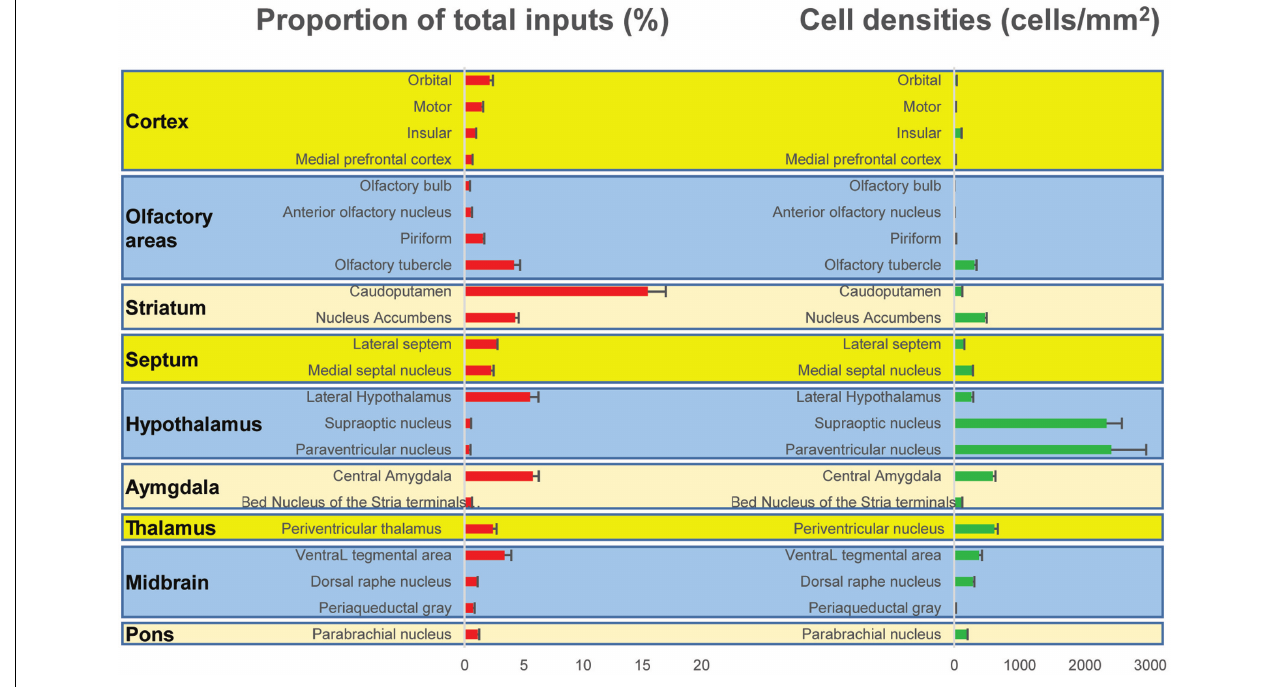
FIGURE 3 | Statistical analysis of the monosynaptic inputs (Left) Proportion of input neurons for BF cholinergic neurons. The values are the normalized ratio of the cell number in each area against the total number of input neurons. Error bars represent the SEM. n = 4 ChAT-Cre mice. (Right) Cell density of input neurons in each brain